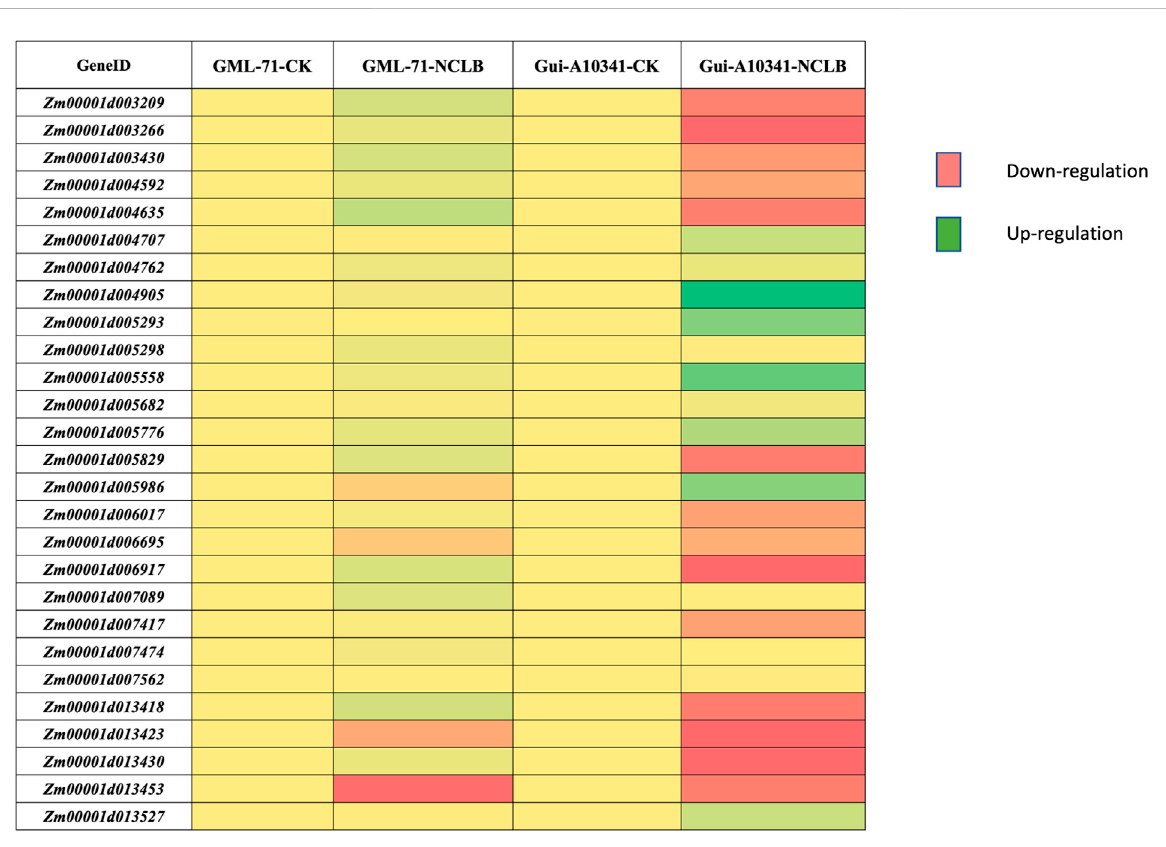
FIGURE 4 Expression pro fi le of candidate genes in two contrasting parental genotypes, GML-71 and Gui A10341. The expression pattern was estimated before (check = CK) and after NCLB inoculation (NCLB) in both